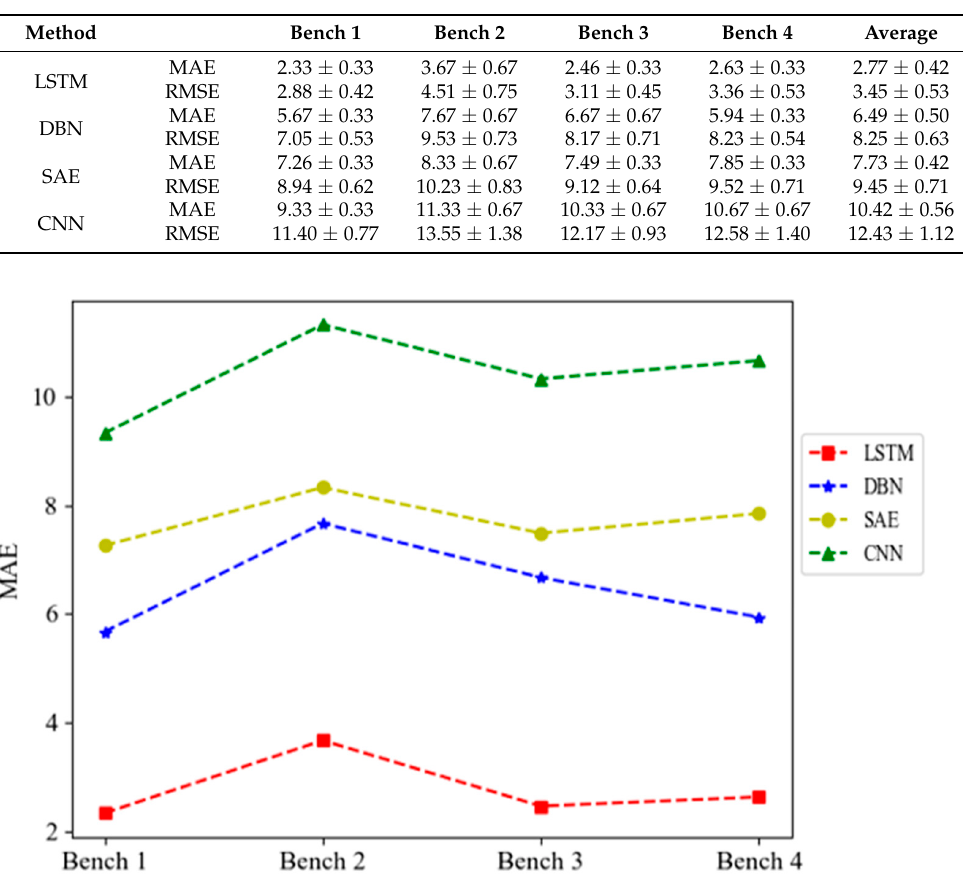
Table 4. MAE and RMSE results under different methods.